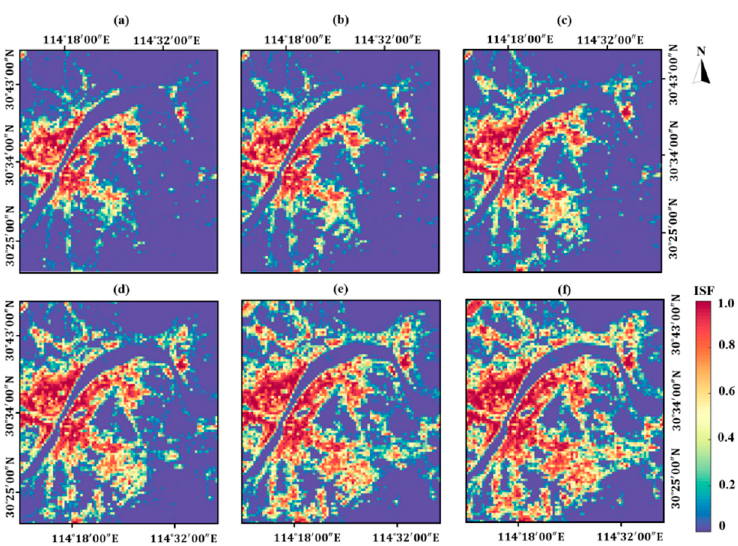
Figure 3. The impervious surface fraction (ISF) maps from 2002 to 2017 in the study area. ( a ) 2002; ( b ) 2005; ( c ) 2008; ( d ) 2011; ( e ) 2014; ( f ) 2017.